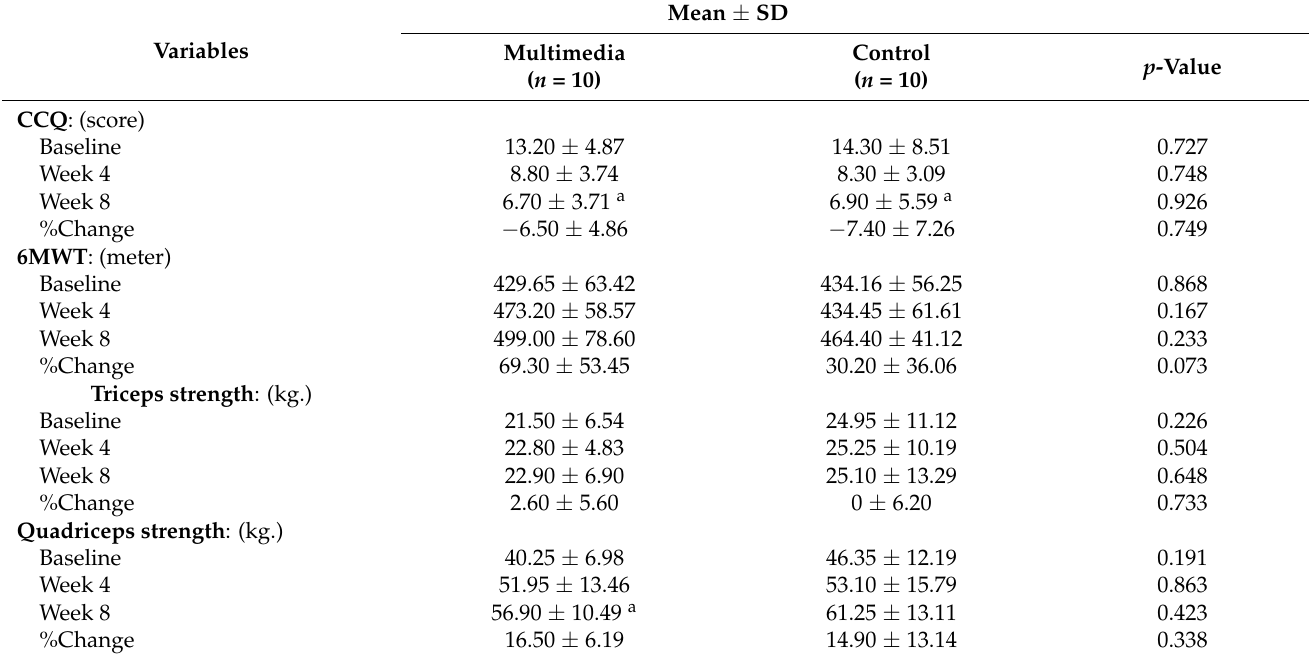
Table 3. Results of clinical COPD questionnaire, 6 min walk test, and muscle strength of upper and lower extremities before and after the home-based pulmonary rehabilitation program between the multimedia and control groups.